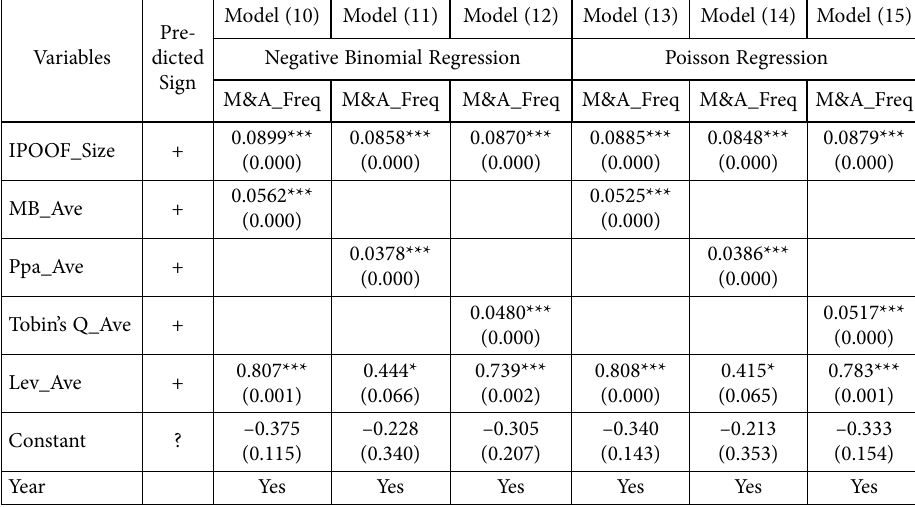
Table 13. IPO over-financing, market overvaluation and transaction